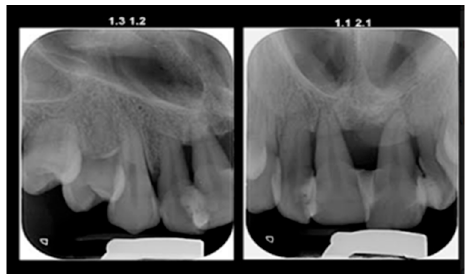
Figure 7. Radiographs after periodontal treatment.